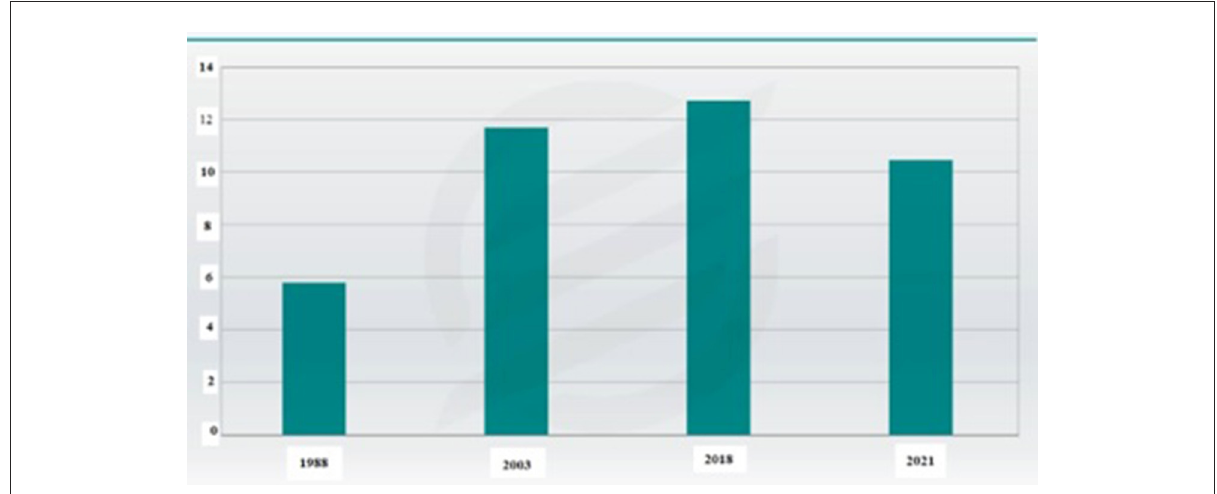
FIGURE1 The trend of changes in the amount of annual wheat production in the past years (unit: million tons). Source: [14].